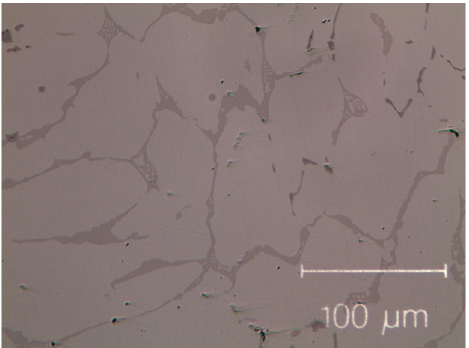
Figure 1. Micro-graph of as-cast Co 19 Cr 19 Ni 19 Fe 19 Mn 19 Zr 5 . Black dots, mainly dispersed in the inter-dendritic phase, are the result of contamination during the milling process.